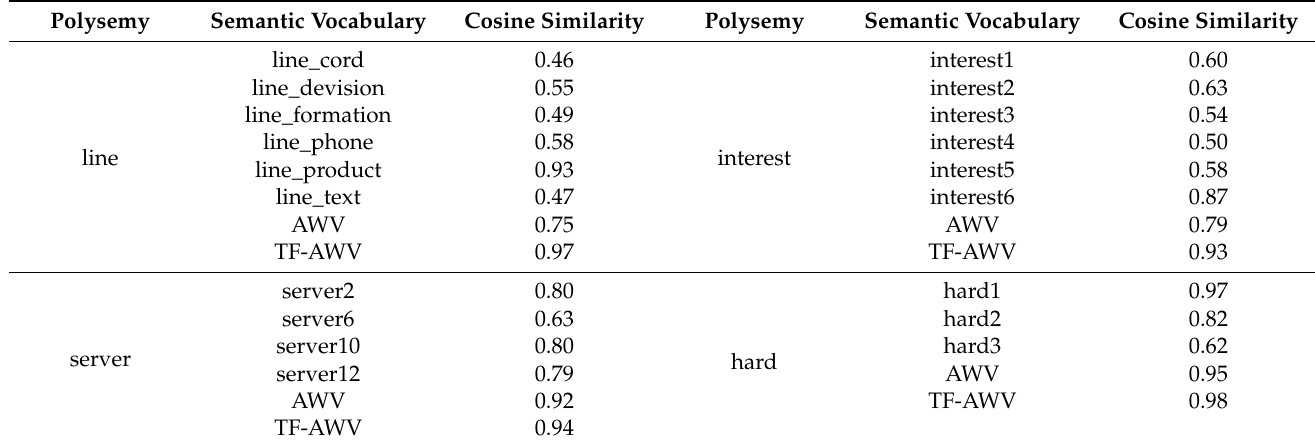
Table 2. Cosine similarity between real word vectors of polysemous words and predicted word vectors based on the two linear combination